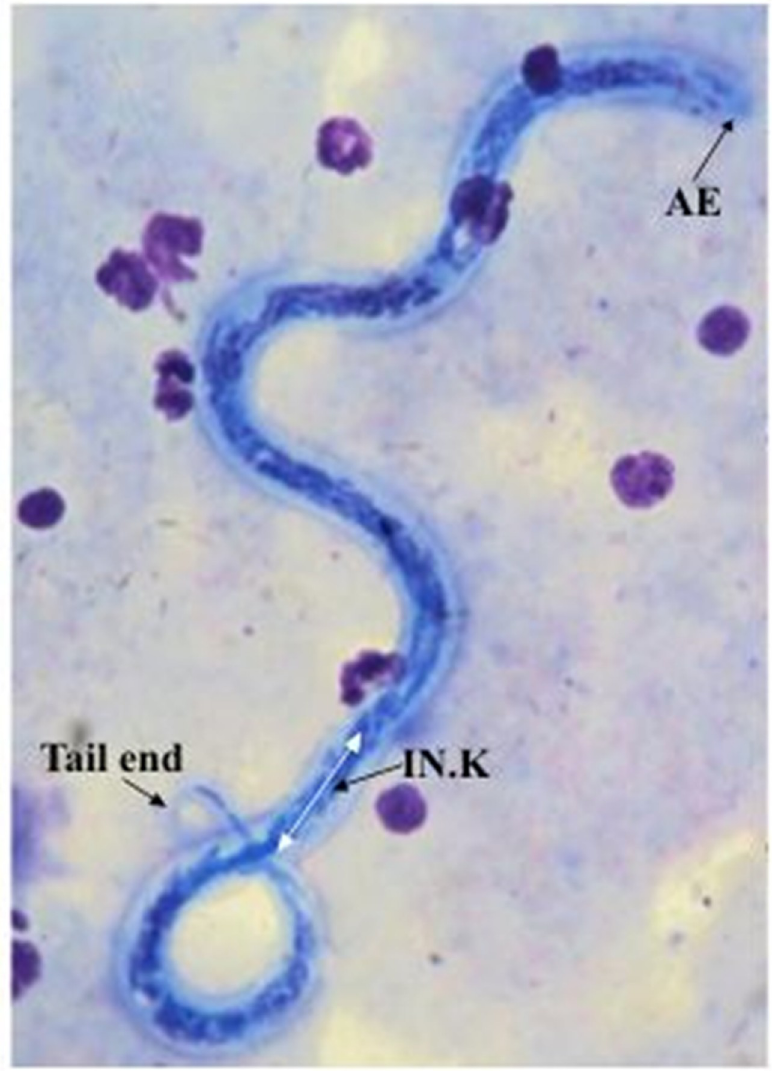
Fig 2. Microfilaria of D . (N . ) repens . AE—Anterior end with two distinct nuclei IN.K.—Innen-